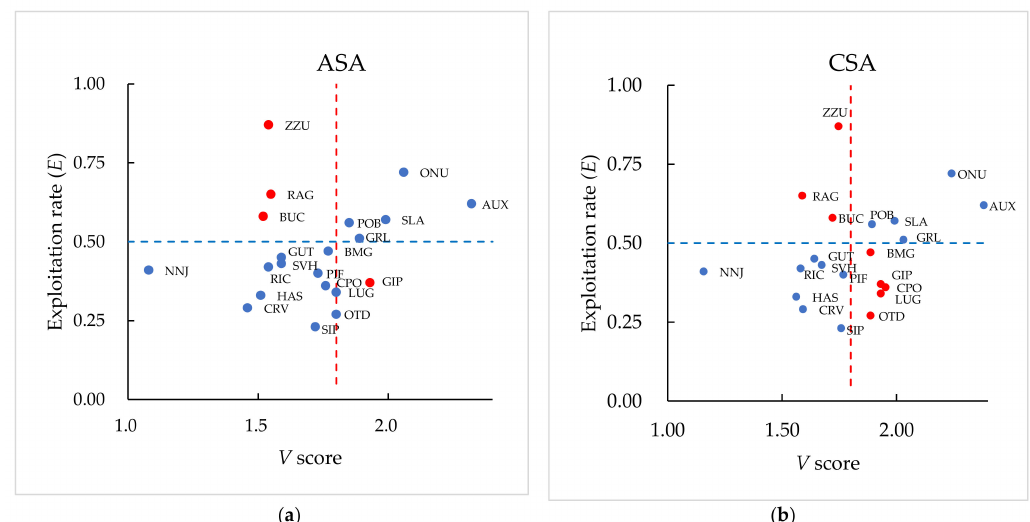
Figure 3. A comparison of the exploitation rates ( E ) and vulnerability scores ( V scores) for the selected bycatches of the Hilsa gillnet fishery in Bangladesh, where the V scores were derived from the productivity susceptibility analysis (PSA) under the alternative scoring approach ( a ) and conservative scoring approach ( b ). Blue- and red-colored solid points represent the consistent and inconsistent cases, respectively, between the E and V scores (when V > 1.8 and E > 0.5 = overfishing, and V ≤ 1.8 and E < 0.5 = underfishing). The 3-alpha FAO species identification codes are presented in Table 1.